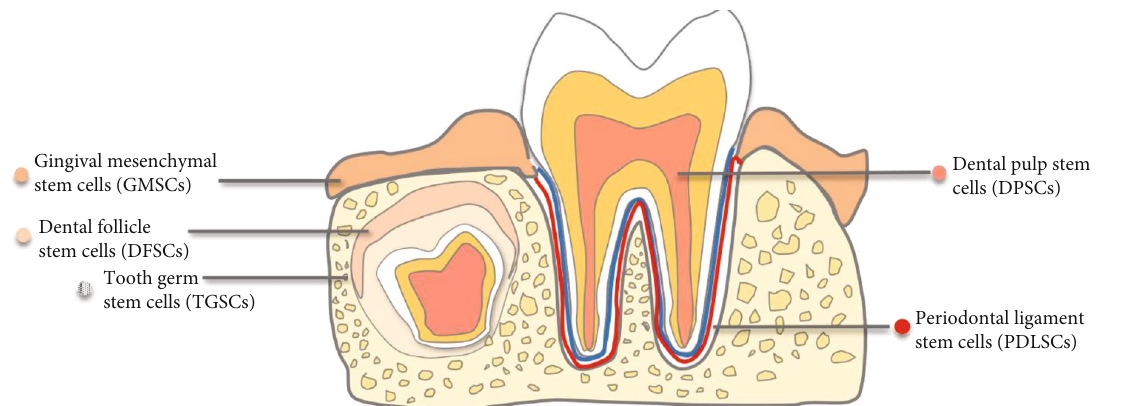
Figure 4: Stem cell distribution in dental tissues. Stem cells are located in gingiva, dental follicle, tooth germ, dental pulp, and periodontal